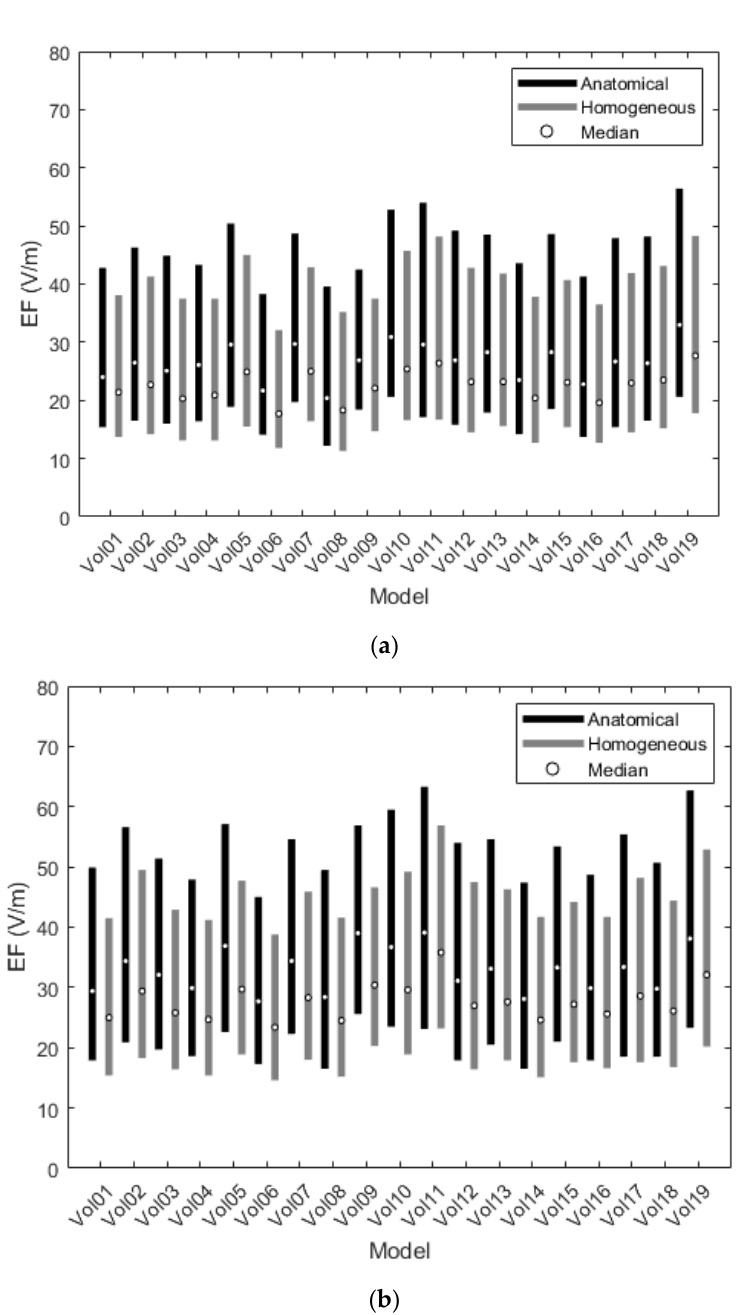
Figure 4. Interquartile ranges of the EF distributions for the frontal ( a ) and central ( b ) coil positions.